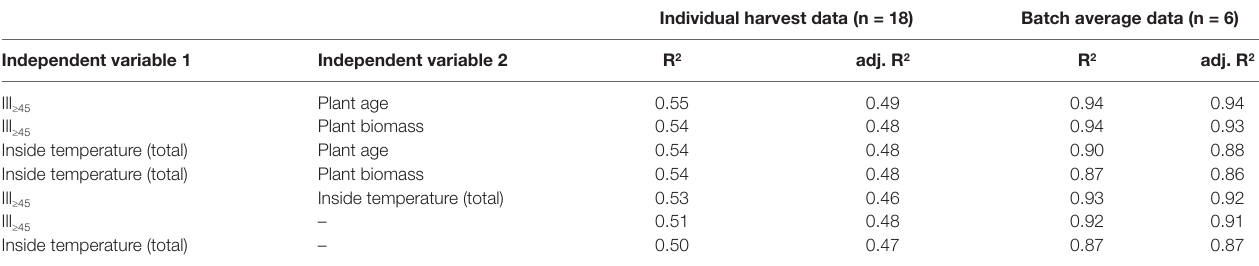
TABLE 3 | Multilinear regression models for DFE yield trained on all data or batch averages of the second set of six